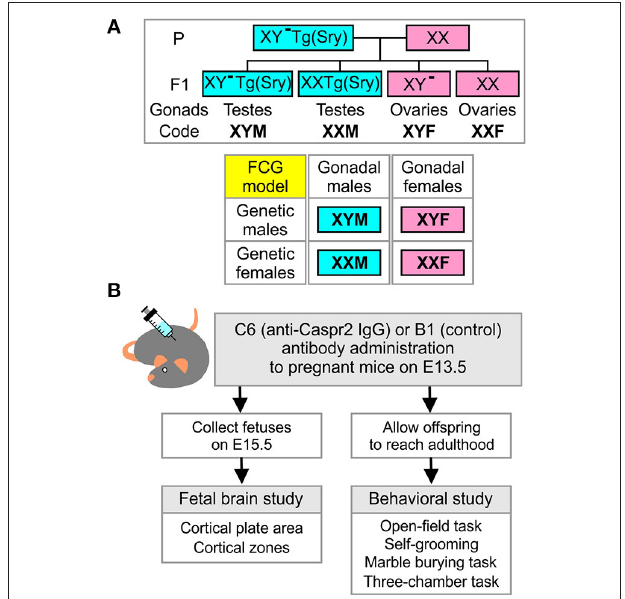
FIGURE 1 | Four-core-genotypes model, combined with in utero exposure to C6, to study maternal antibody-induced model of ASD. (A) Description of the four-core-genotypes (FCG) model in which a C57Bl/6J female mouse (XX) is mated with a XY − ( Sry ) male mouse (XYM) to generate offspring in which gonadal and chromosomal contributions can be separately studied. (B) Description of the experimental plan for the fetal brain and behavioral